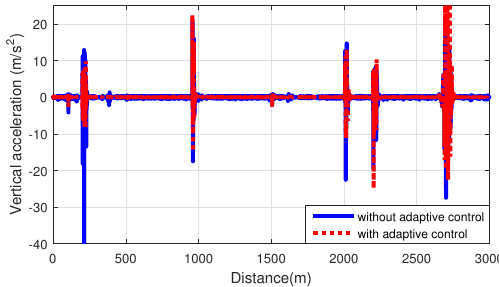
Figure 13. Vertical acceleration.